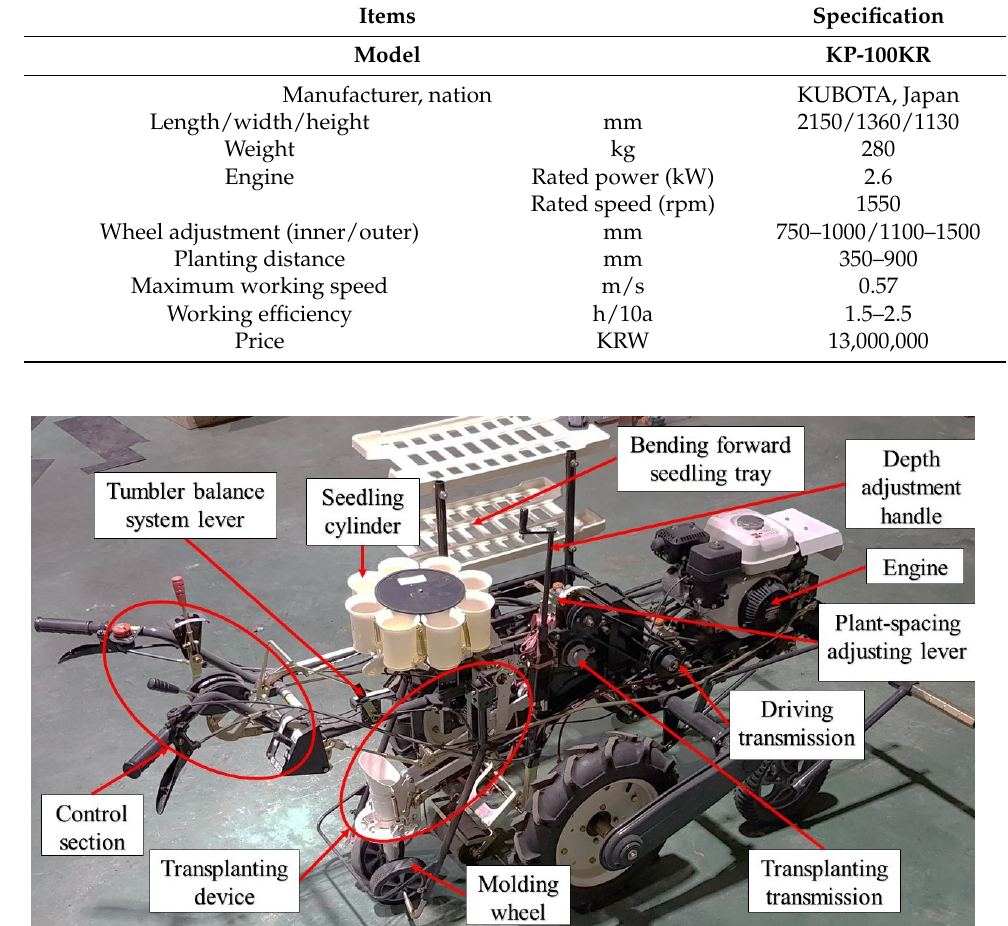
Figure 2. View of four-bar-link semi-automatic vegetable transplanter. Table 2. Main specifications of the four-bar-link semi-automatic vegetable transplanter.